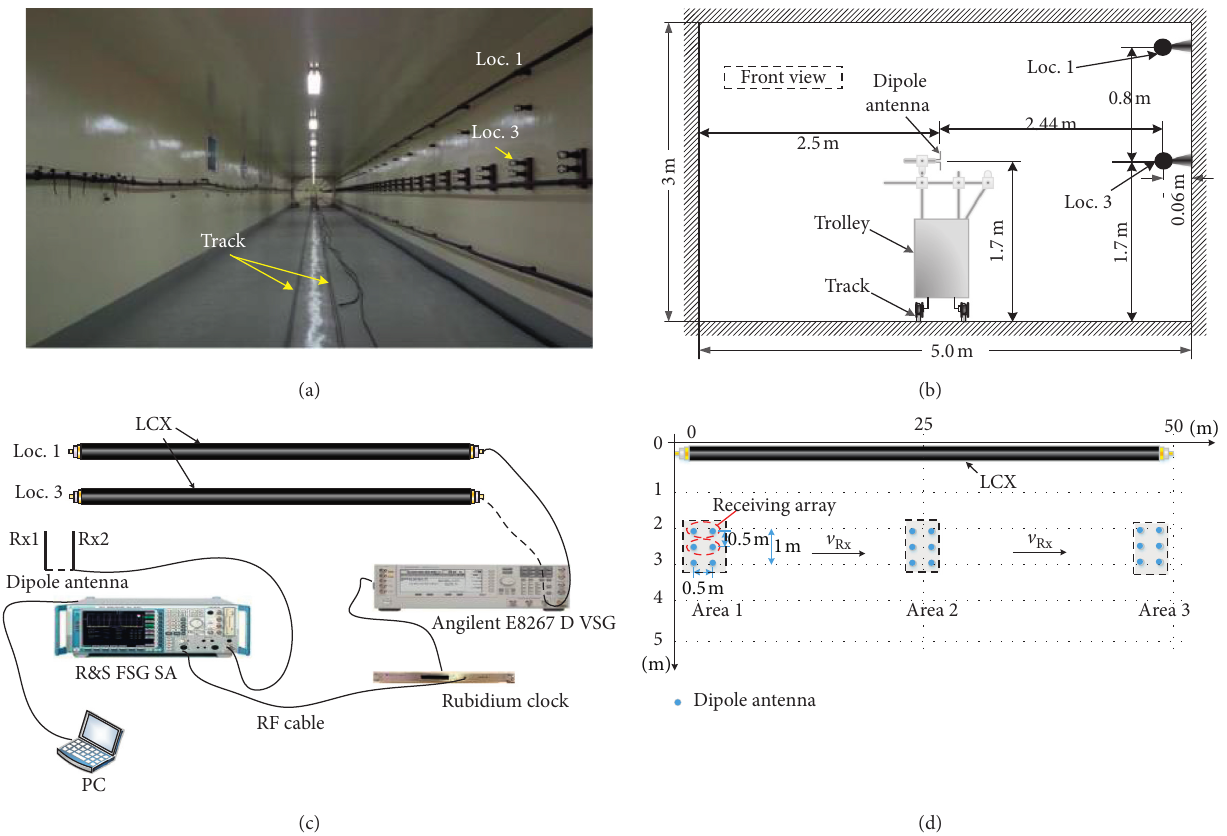
Figure 2: Experiment scenario description of Nantong tunnel: (a) photograph of the tunnel; (b) the front view of the tunnel; (c) experiment configuration of LCX-MIMO system; (d) top view of the tunnel.